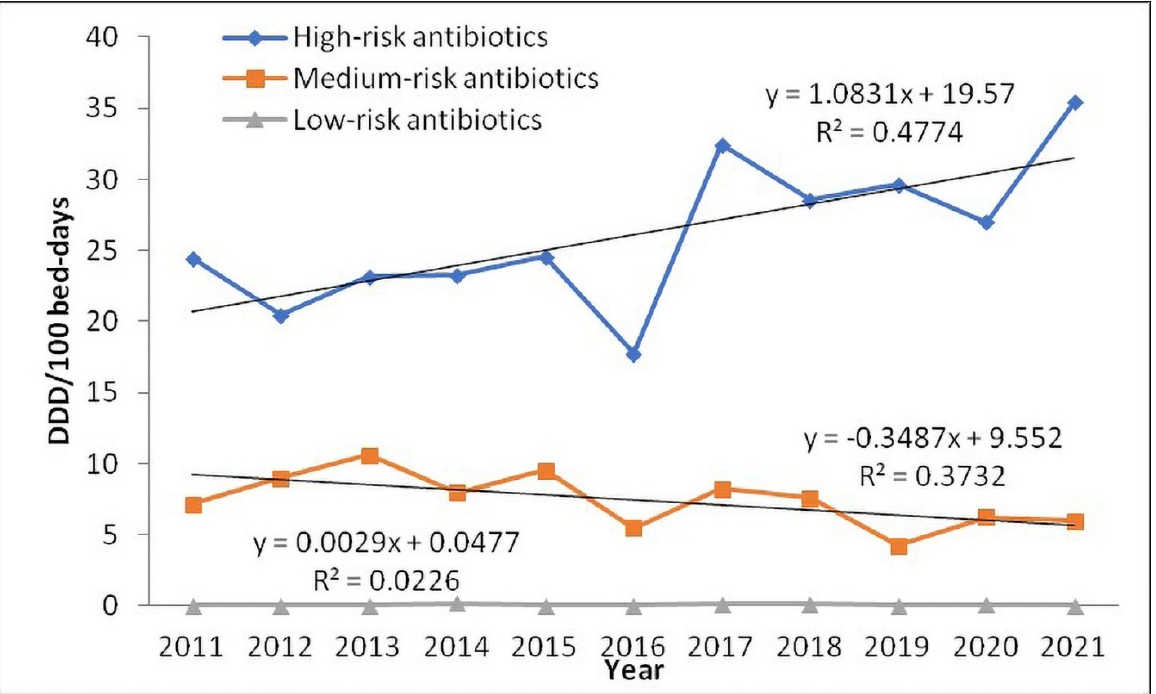
Figure 3. Trend in antibiotic consumption in defined daily doses (DDD) per 100 bed-days from 2011 to 2021 based on the risk of Clostridium difficile infection. High-risk antibiotics, Mann-Kendall test; p = 0.186; Medium-risk antibiotics, Mann-Kendall test; p = 0.010; Low-risk antibiotics, Mann-Kendall test; p = 0.873.